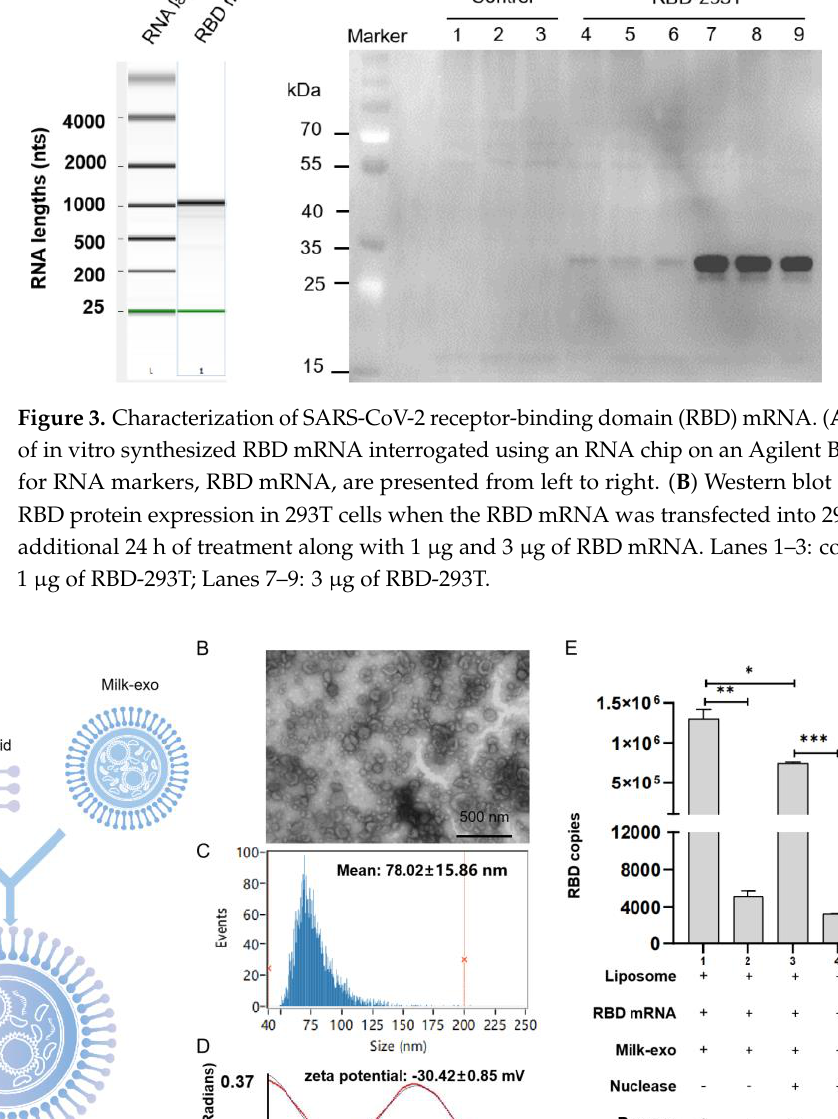
Figure 3. Characterization of SARS-CoV-2 receptor − binding domain (RBD) mRNA. ( A ) Gel − like image of in vitro synthesized RBD mRNA interrogated using an RNA chip on an Agilent Bioana- lyzer. Data for RNA markers, RBD mRNA, are presented from left to right. ( B ) Western blot for SARS-CoV-2 RBD protein expression in 293T cells when the RBD mRNA was transfected into 293T cells with an additional 24 h of treatment along with 1 μg and 3 μg of RBD mRNA. Lanes 1 – 3: